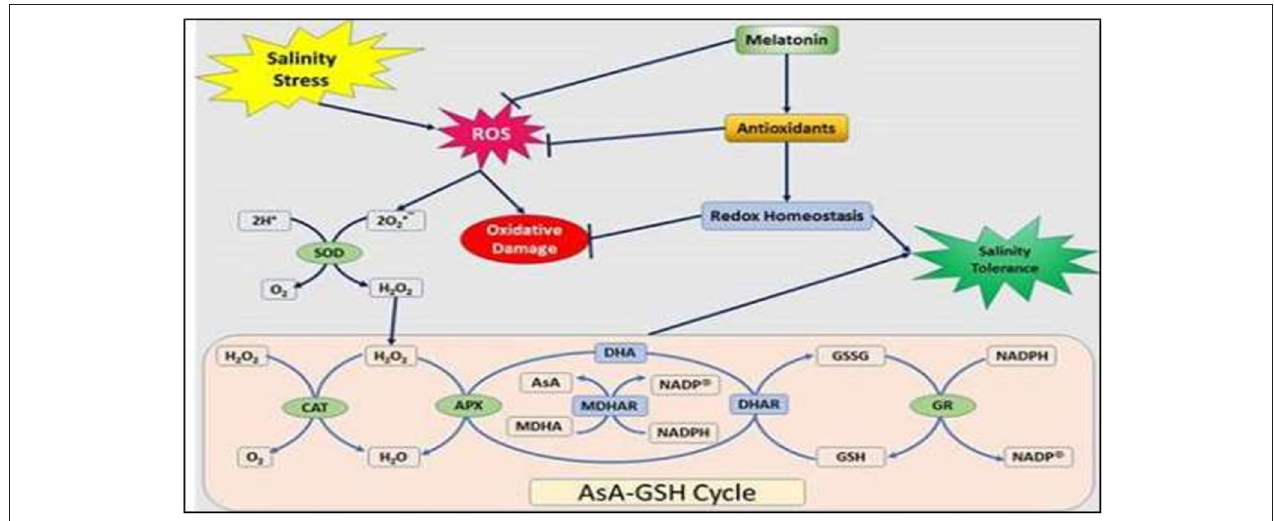
FIGURE 4 | Schematic presentation of the ascorbate–glutathione cycle and a model depicts the melatonin-induced alleviation of NaCl-caused oxidative stress in peanut plants. ROS, reactive oxygen species; SOD, superoxide dismutase; CAT, catalase; APX, ascorbate peroxidase; AsA, ascorbate; MDHA(R), monodehydroascorbate (reductase); NADPH, nicotinamide adenine dinucleotide phosphate, DHA, dehydroascorbate; DHAR, dehydroascorbate reductase; GSH, reduced glutathione; GSSG, oxidized glutathione; and GR, glutathione reductase ( ElSayed et al.,